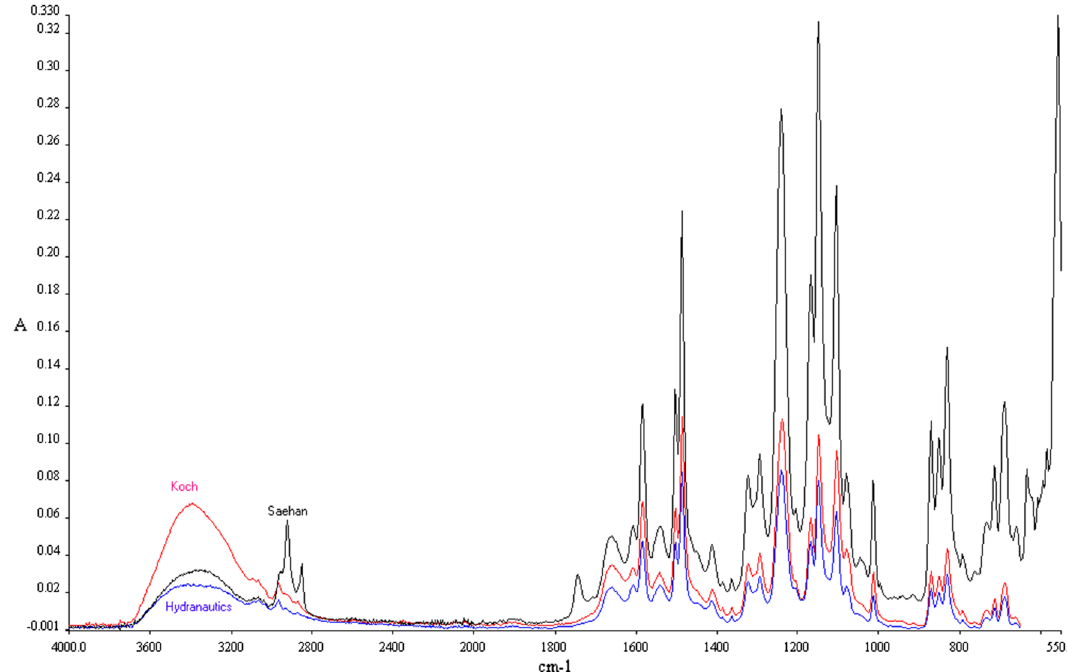
Fig. 4 FTIR spectra of the three virgin